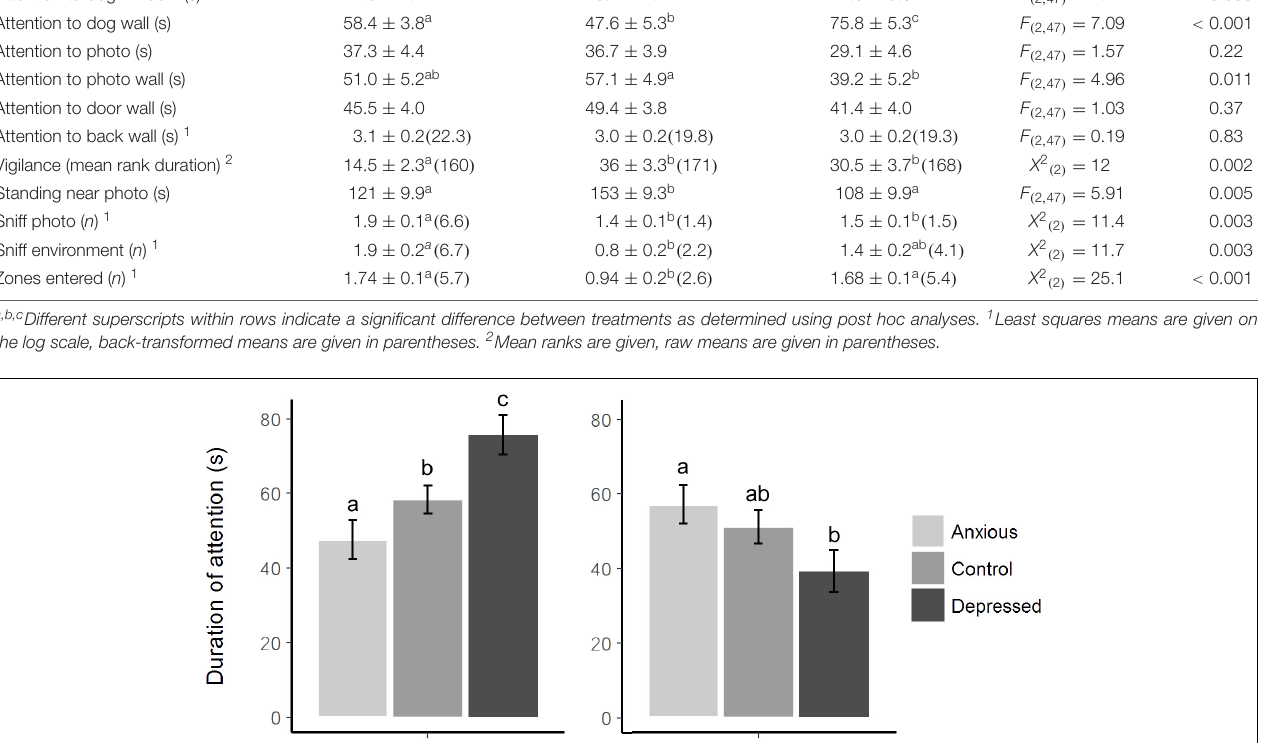
Looking at Looking at photo (%) window (%)